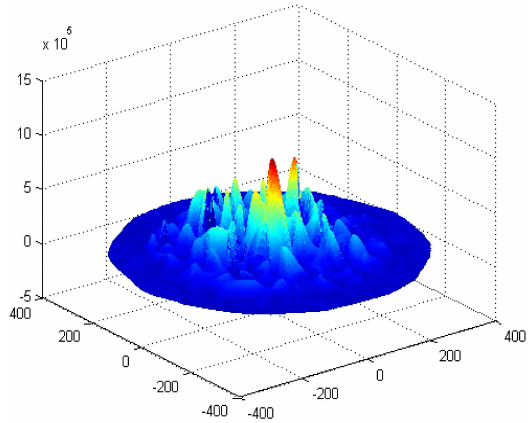
Figure 9. The energy consumption in the ACK-based